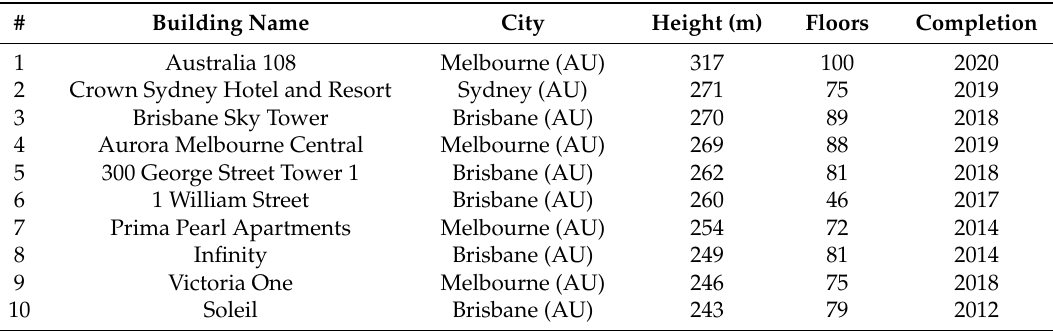
Table 9. Oceana’s 10 tallest skyscrapers in 2020.